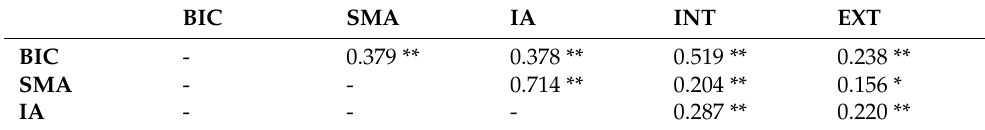
Table 2. Bivariate correlations among the variables of interest for the total sample.